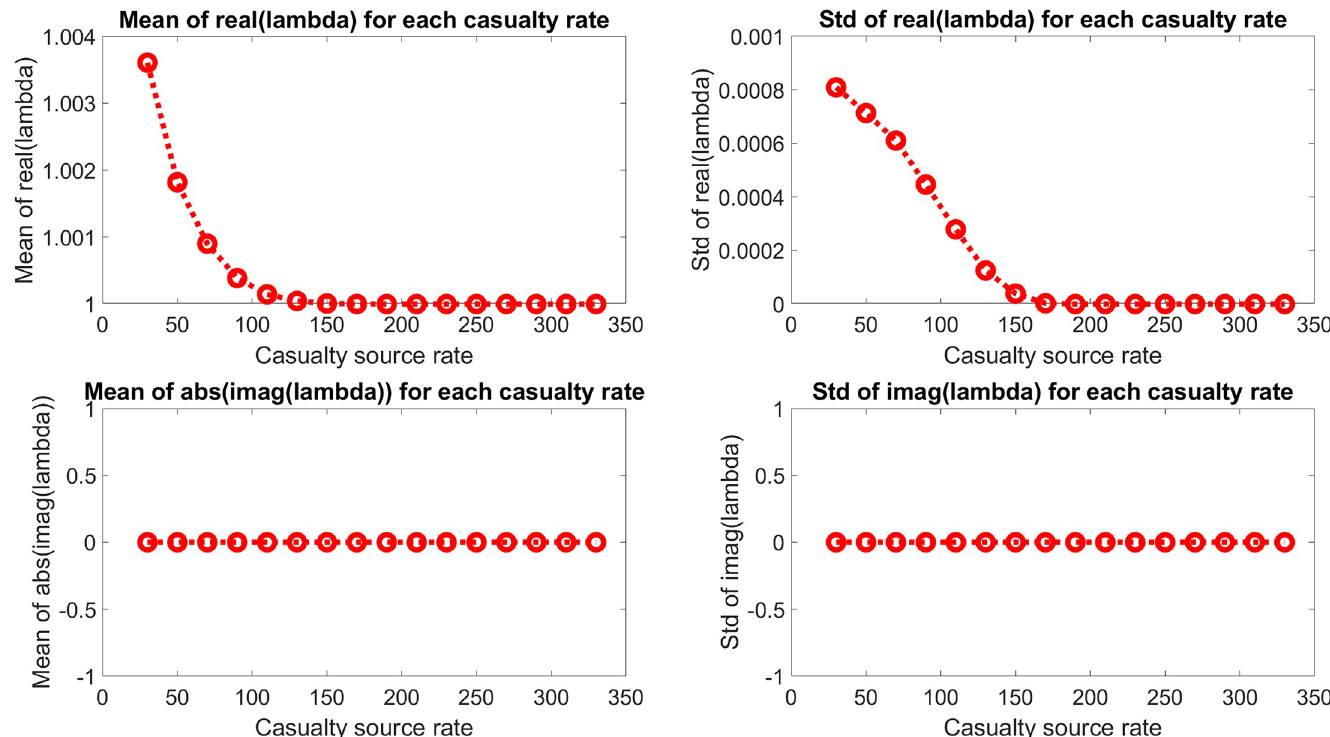
Fig 8. Mean and standard deviation of eigenvalue distribution of dominant mode for each casualty source rate. The dominant mode eigenvalues are seen to not varying significantly with casualty source rate.